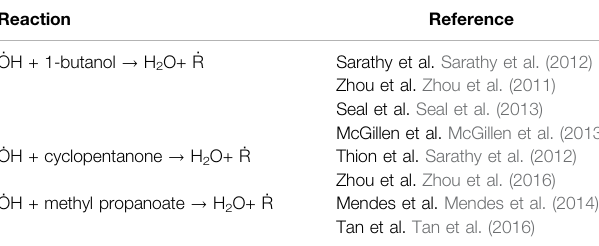
TABLE 2 | References for rate coef fi cients for O ̇ H-initiated H-abstraction from 1- butanol, cyclopentanone, and methyl propanoate.